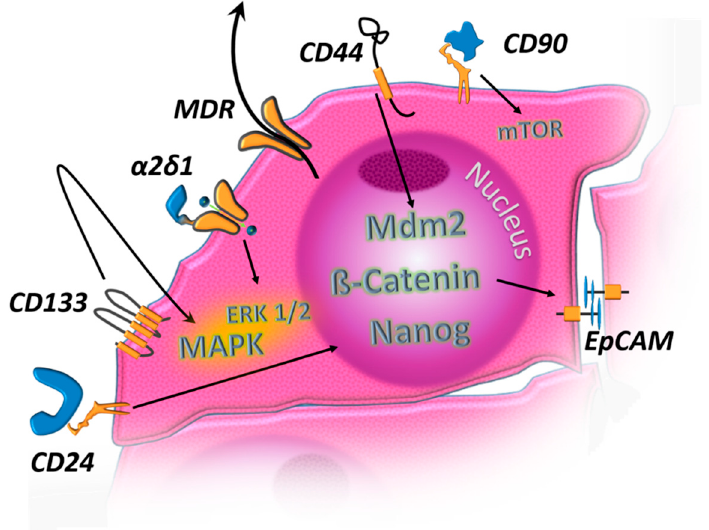
Figure 1. Established markers for cancer stem cells in hepatocellular carcinoma (HCC) and possible functions. MDR: multidrug resistance protein, ATP-dependent substrate export; α 2 δ 1: calcium voltage-gated channel auxiliary subunit Alpha2Delta1, calcium channel; EpCAM: epithelial cell adhesion molecule, single-trans-membrane cell surface adhesion molecule; CD133: prominin 1, pentaspan transmembrane molecule; CD24, CD90: GPI-anchored cell surface molecules; CD44: single-trans-membrane cell surface molecule with multiple functions, including cell–matrix and cell–cell interactions. mTOR: mammalian target of rapamycin. Mdm2: murine double minute 2. MAPK: mitogen activated protein kinases. ERK: extracellular signal-regulated kinases.